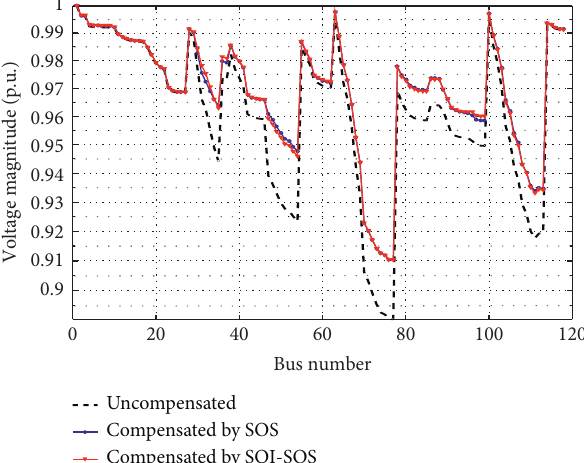
Figure 21: Voltage profile of the 119-bus system before and after compensation with the mixed load model.